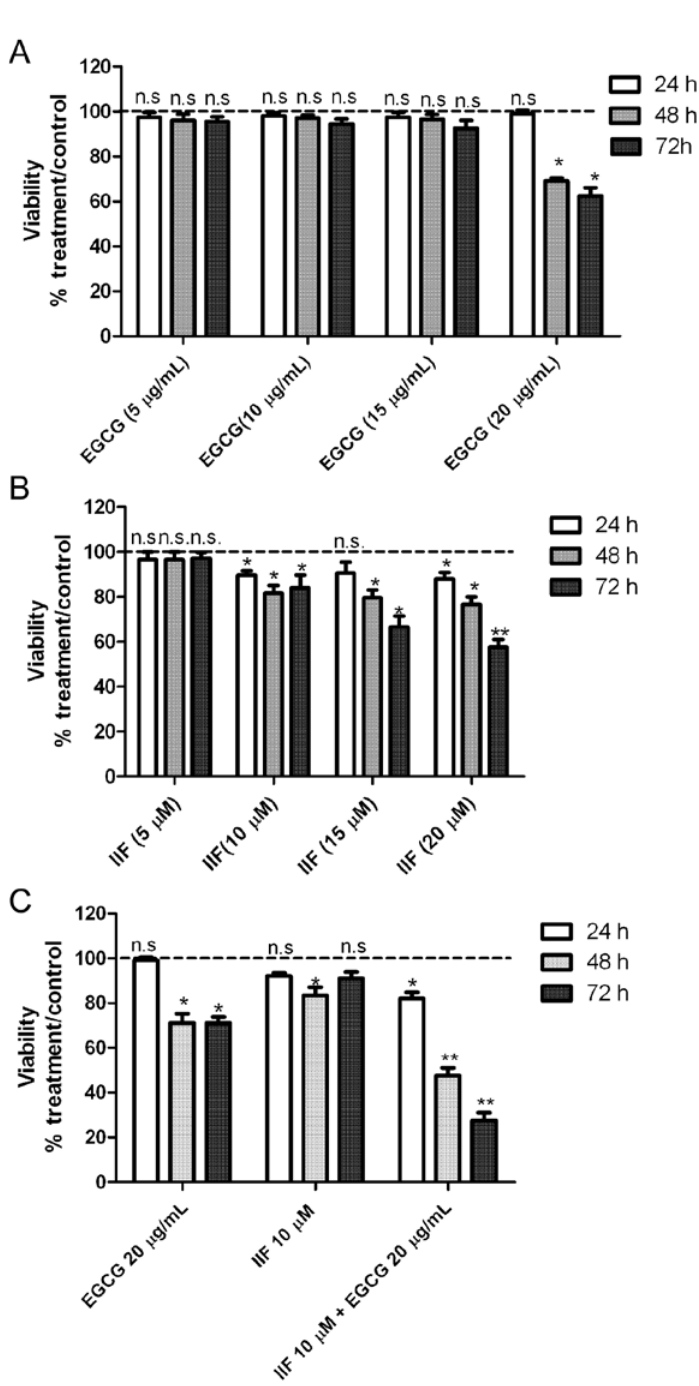
Figure 3. Inhibitory effects of EGCG and IIF treatments on BE(2)-C neuroblastoma cell growth as evaluated by 3-(4,5-dimethylthiazol-2-yl)-2,5-diphenyl tetrazolium bromide (MTT) assay. ( A ) EGCG